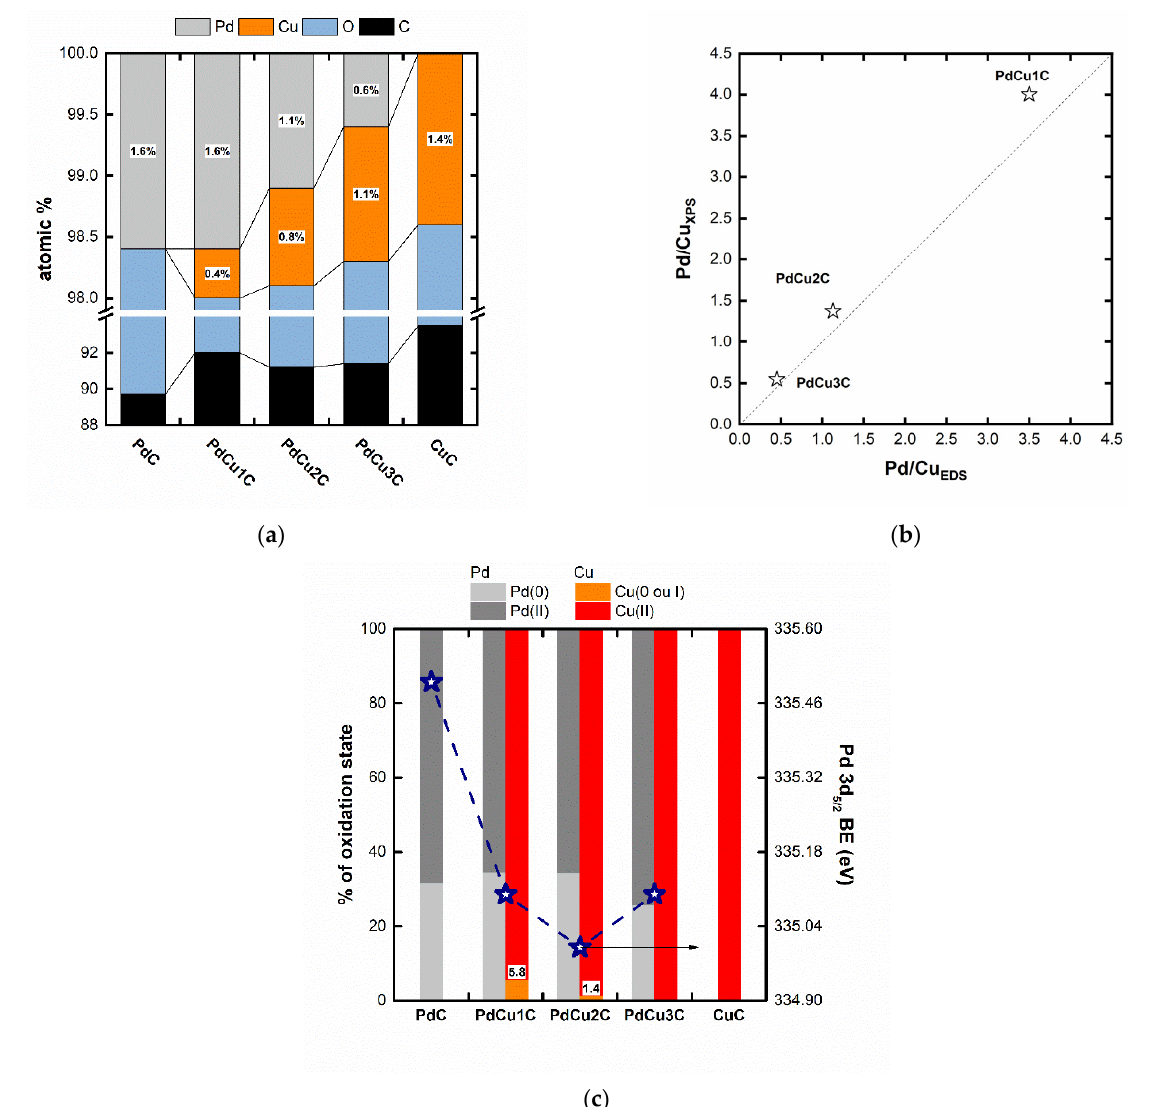
Figure 3. ( a ) Surface atomic composition of the different catalysts; ( b ) surface vs. bulk Pd/Cu atomic ratio for the bimetallic materials; and ( c ) proportion of the oxidation state of each metal and Pd 3d 5/2 of each catalyst and Pd 3d 5/2 binding energy for the Pd-based catalysts.